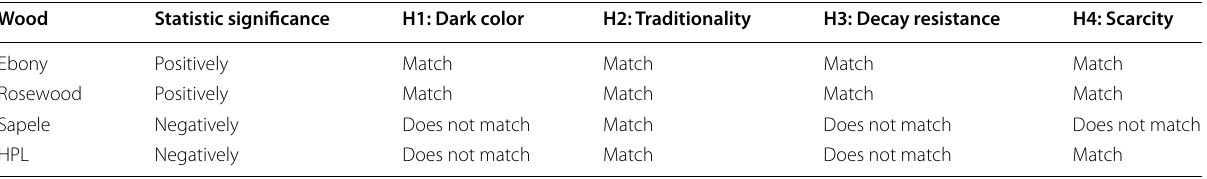
Table 7 Results of stepwise method for Martin (Analysis